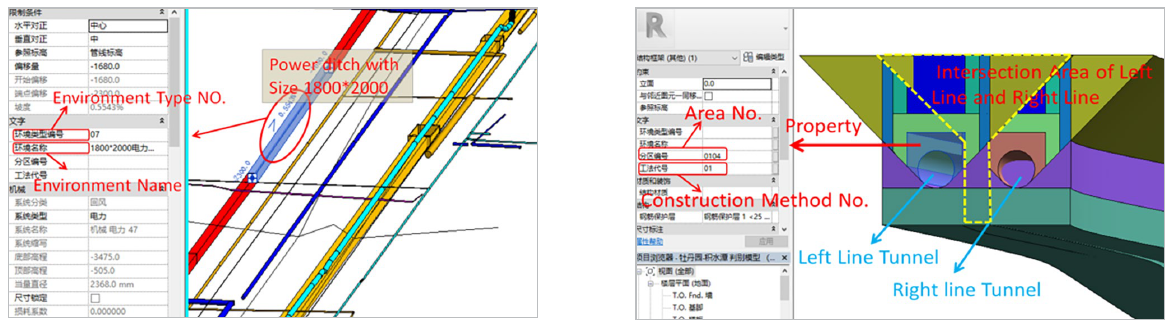
platformFigure 13. Discriminant models and pipeline models created using